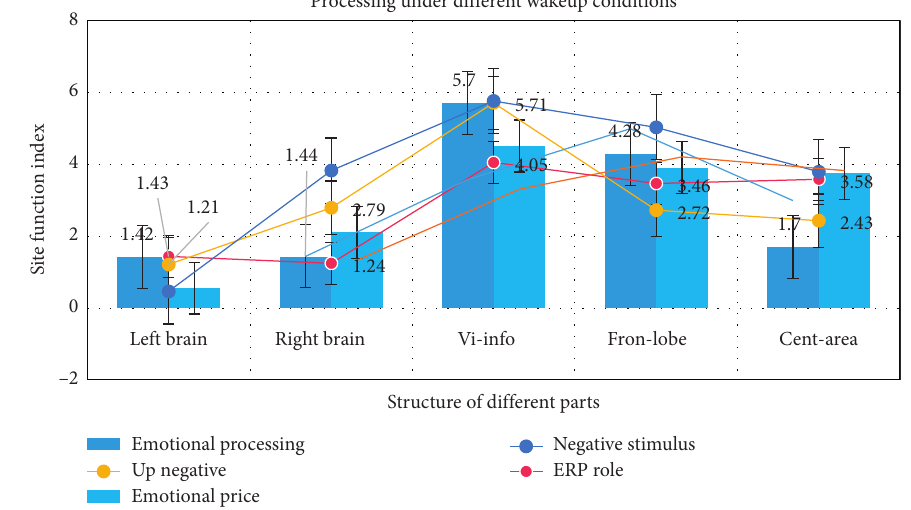
Figure 13: Processing under different wakeup